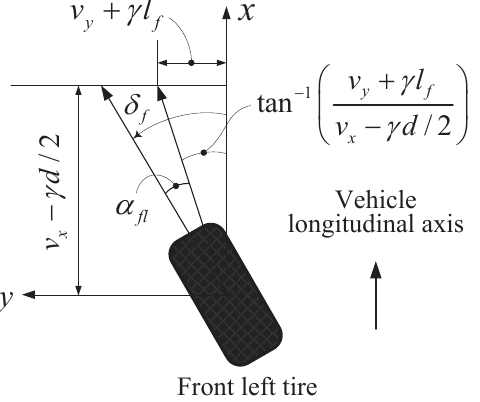
Figure 5. Calculation of the slip angle of a front left tire based on geometric